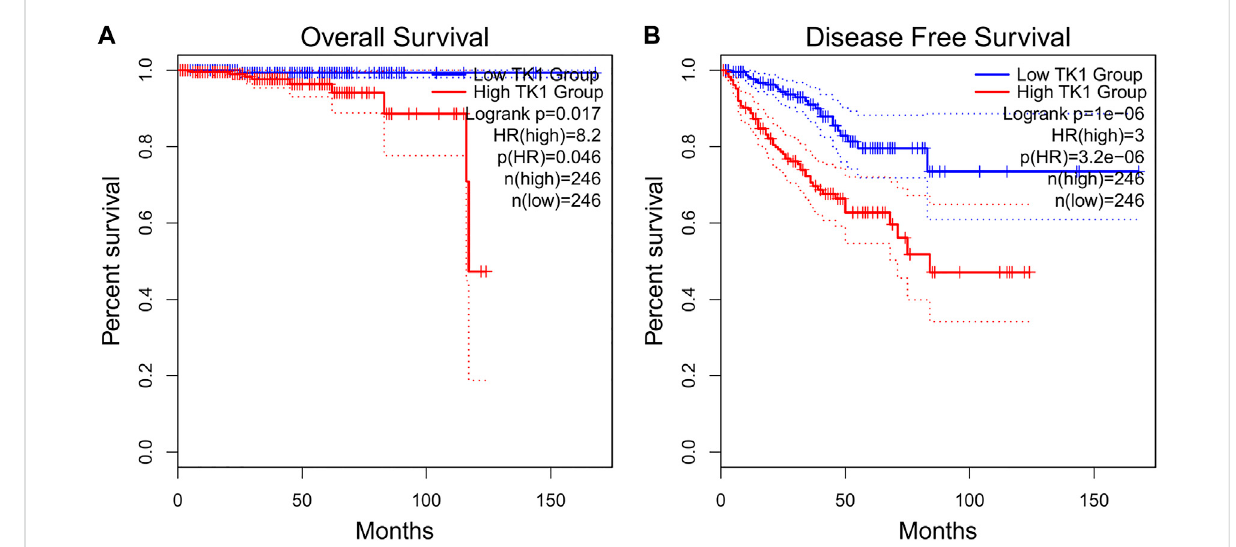
FIGURE 2 PrognosticvalueasaresultofTK1inPCapatients. (A,B) GEPIApro fi lingshowedthatPCapatientswithhighTK1expressionwereassociatedwith poorer OS. (A) and PFS (B) relative to those with low TK1